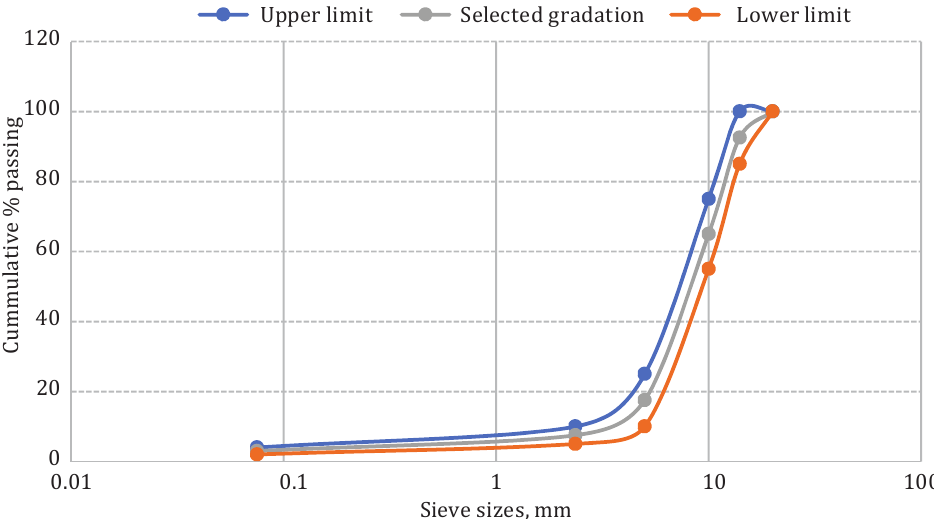
Figure 1. Specified limiting curves for the porous asphalt